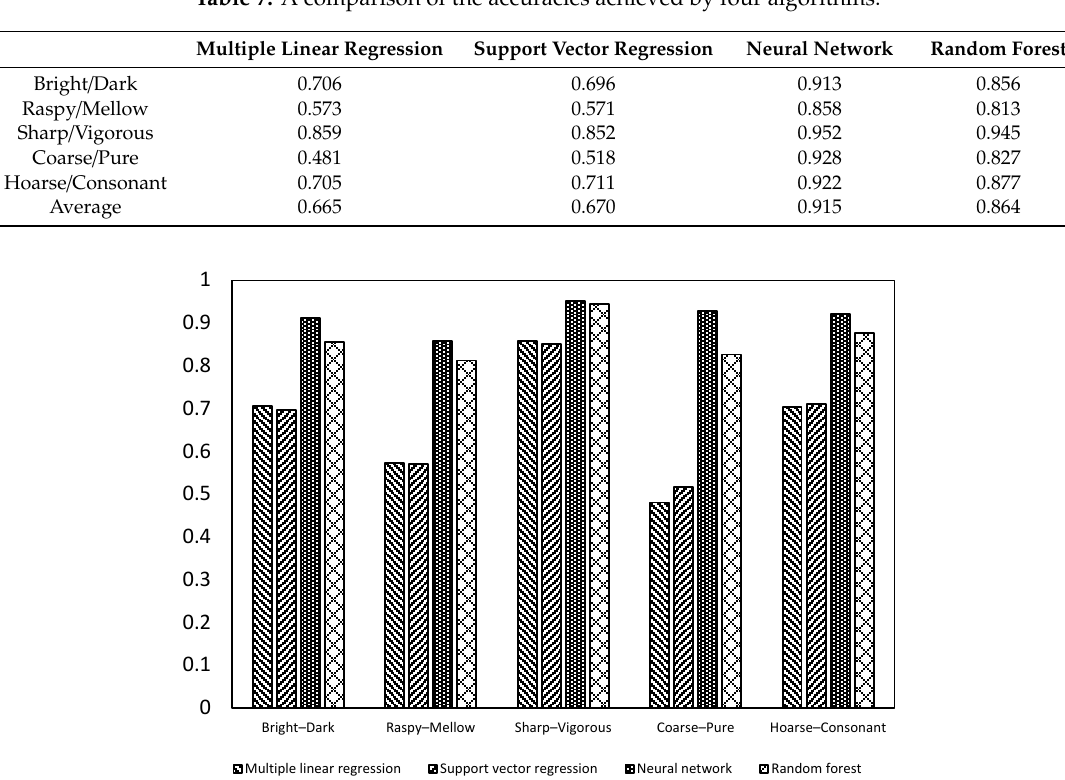
Figure 5. A prediction accuracy histogram for the five perception attributes.